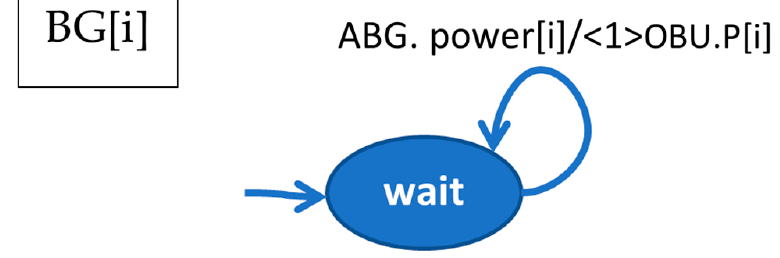
Figure 9. The automaton modeling an ith balise ( BG [i]).